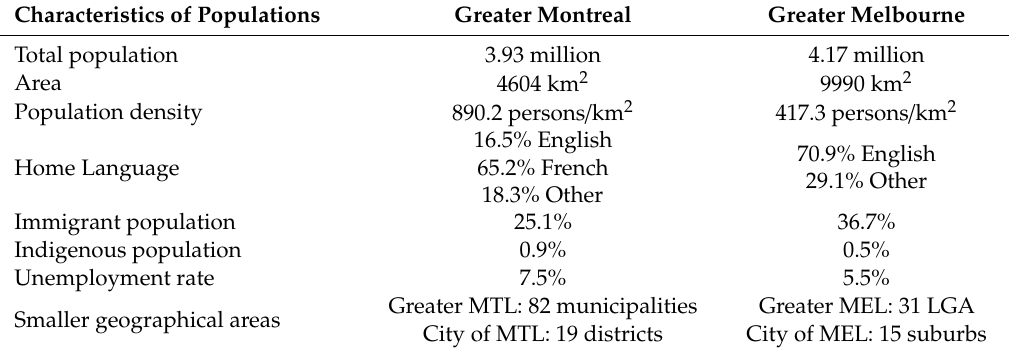
Table1. CharacteristicsofpopulationsinthemetropolitanMontrealandMelbournein2011(Information extracted from [21,22]